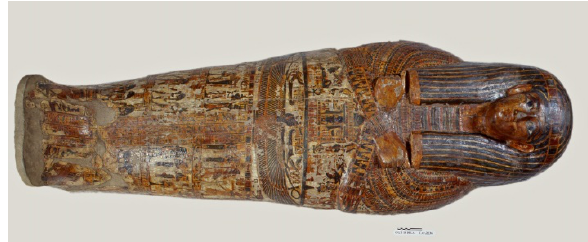
Figure 1. The external coffin of Butehamon, from the catalogue of the Museo Egizio, Turin.